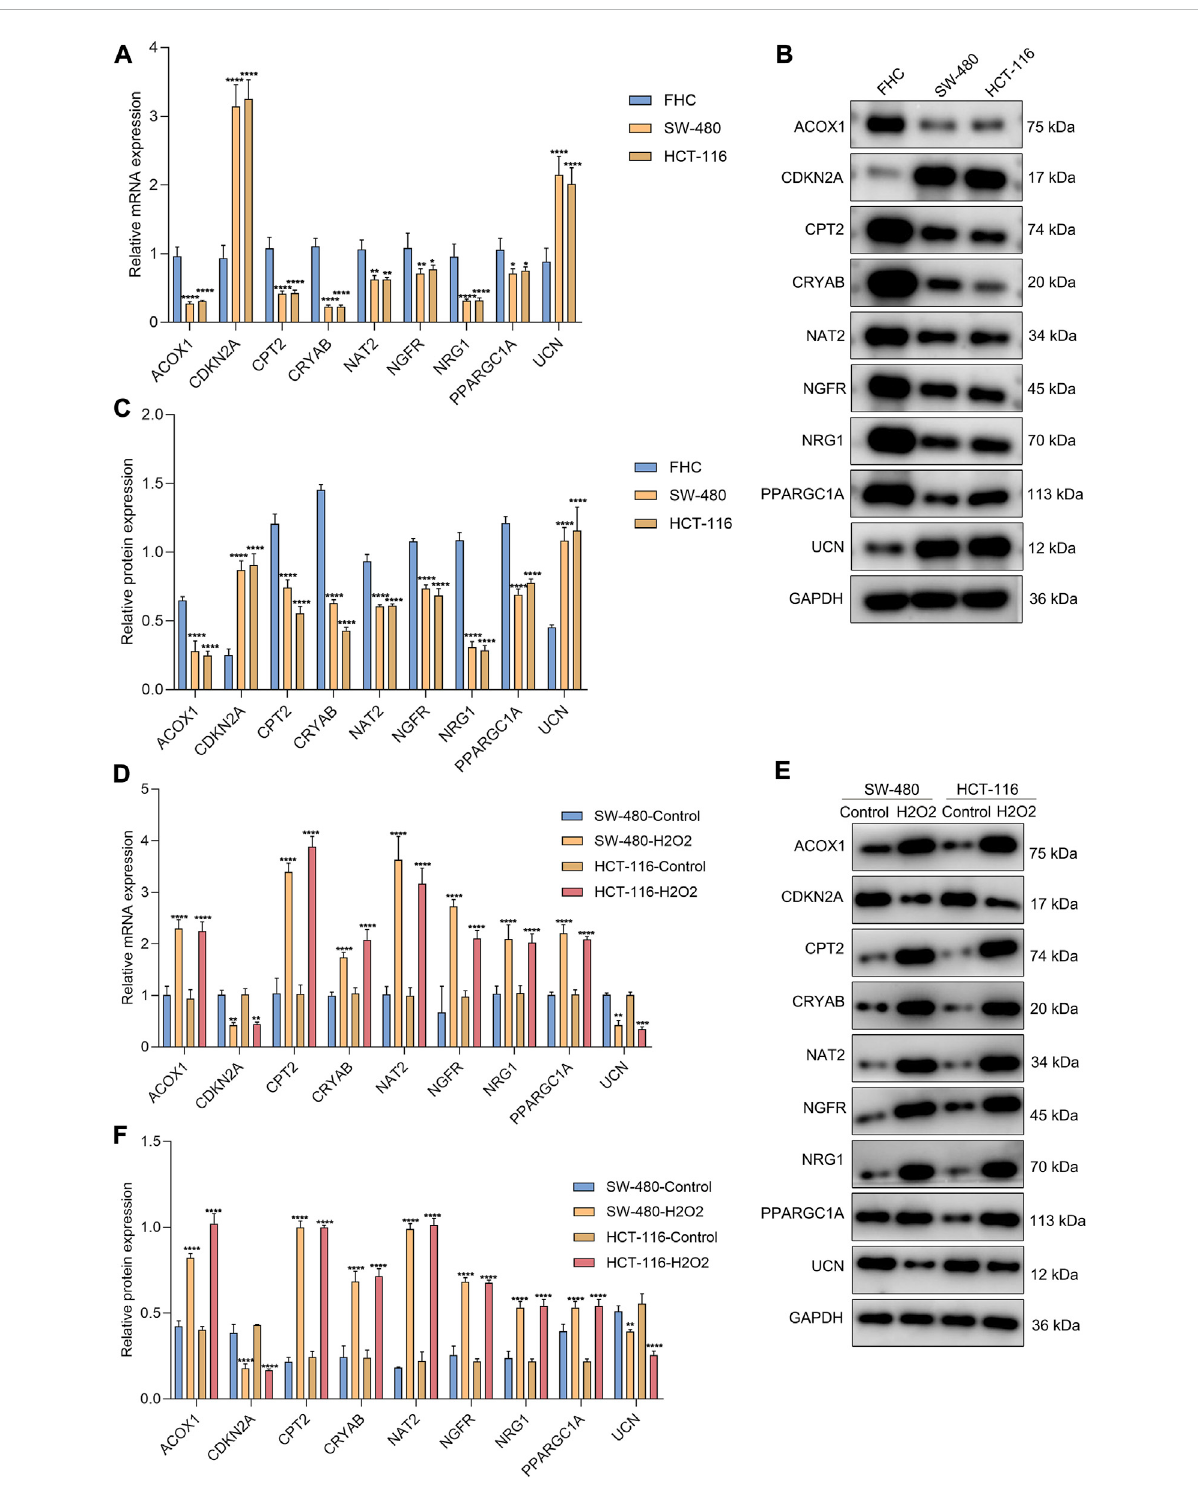
FIGURE 9 Experimentalveri fi cationofthegenesfromtheoxidativestress-relevantgenesignature. (A – C) RT-qPCRandWesternblotfortheexpressionof ACOX1 , CPT2 , NAT2 , NRG1 , PPARGC1A , CDKN2A , CRYAB , NGFR ,and UCN inFHC,SW-480,andHCT-116cells. (D – F) RT-qPCRandWesternblotfor their expression in H 2 O 2 -induced SW-480 and HCT-116 cells. * p < 0.05; ** p < 0.01; *** p < 0.001; **** p < 0.0001. N =